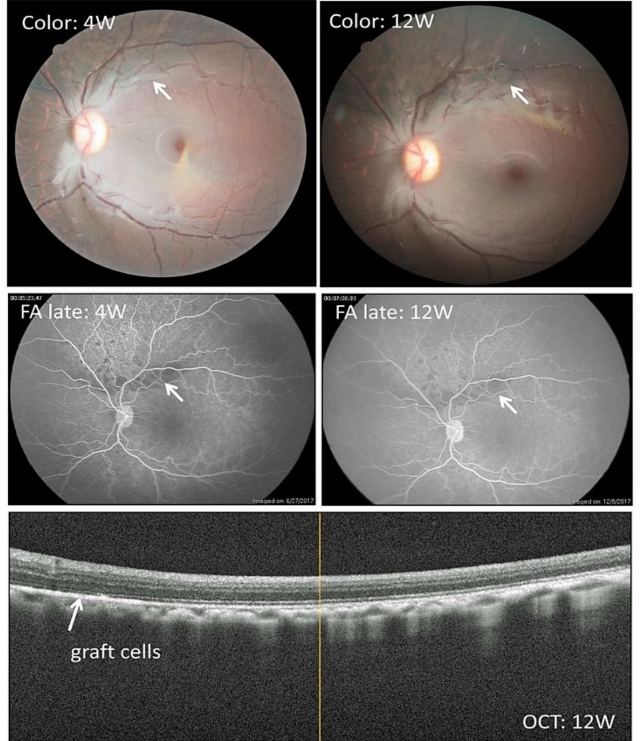
Figure 5. Clinical features after iPS-RPE cell transplantation together with Y-27632 in an allogeneic monkey. Representative color fundus, fluorescence angiography (FA), and OCT images are shown for the allogeneic transplantation using a normal healthy monkey (Hekoayu) and a monkey with iPS- RPE cells (single cell suspensions; 46a line). Before transplantation, we administrated cyclosporine A. In the operation, we injected iPS-RPE cells together with Y-27632 in the subretinal space. Pigmented cells became visible by 4 weeks (4W) after the transplantation, with a stable pigmented area observed at 12 weeks (12W) in this case (white arrows). There were no rejection signs in FA (e.g., no leakages from the graft cells: middle panels). In OCT (lower panel), we can see graft RPE cells in the subretinal space (white